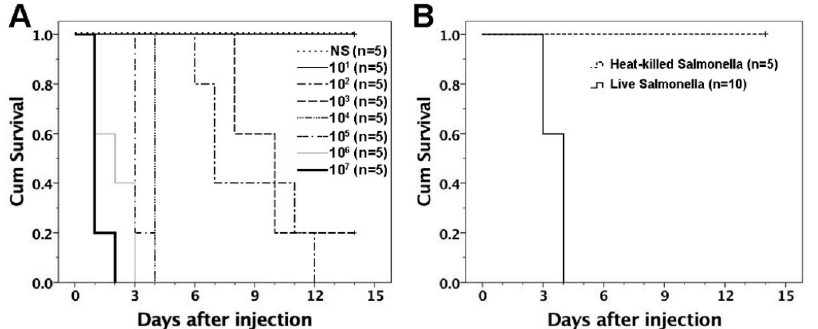
Figure 2. Survival curves after intraperitoneal injection of S. Typhimurium in FVB/N mice. ( A ) FVB/N mice at 2–3 months old were subjected to intraperitoneal injection of S. Typhimurium at various doses of 10 1 –10 7 . Mice died of infection when the Salmonella dose was ≥ 10 2 . The survival of mice following intraperitoneal Salmonella challenge was dose responsive (NS-10 1 vs. 10 2 –10 3 , p = 0.002–0.014; 10 2 –10 3 vs. 10 4 –10 5 , p = 0.002–0.003; 10 4 –10 5 vs. 10 6 –10 7 , p = 0.002–0.042). ( B ) Live